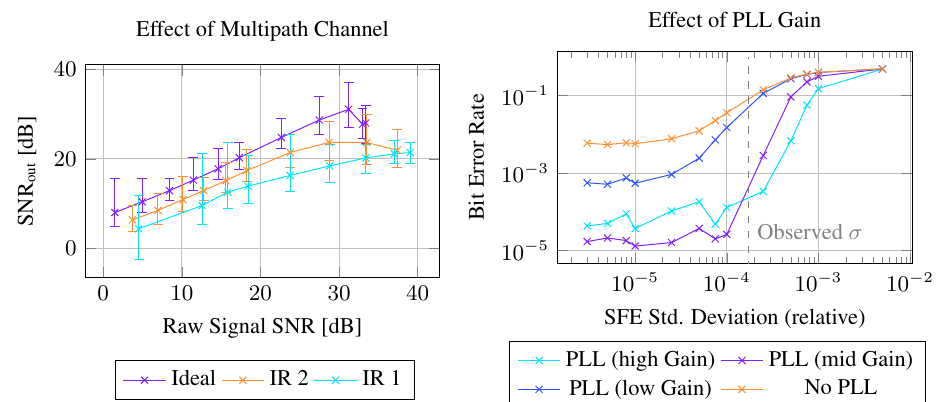
Figure 16. Using simulated signals, the influence of the channel impulse response on the output noise of the decoder is characterized ( left ), where IR1 is the recorded channel impulse response from the 3 m channel at f c = 225 kHz, and IR2 is from the 2 m channel at f c = 210 kHz. Furthermore, the PLL gain is an important parameter to choose depending on SFE variability ( right ). The simulation generated signals with an SNR of 15 dB during this evaluation.